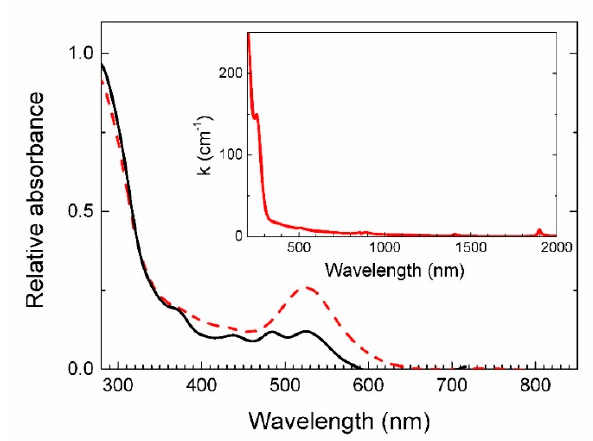
Figure 14. Diffuse optical absorption spectra of the fedorite samples Gav-43 (dashed red curve) and Irk-53 (solid black curve). In the inset, the absorption spectrum of the crystal plate of the sample Gav- 43 measured in the transmission regime is given.